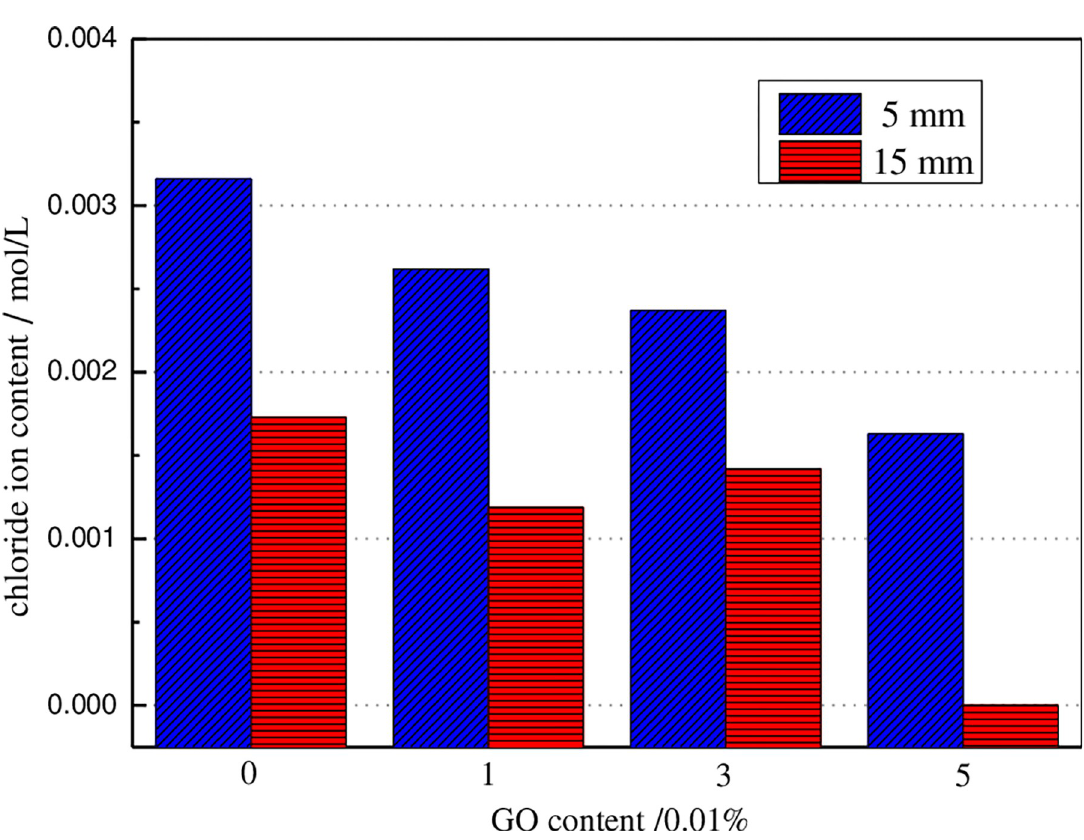
Fig 8. The relationships between the amount of GO and chloride content in